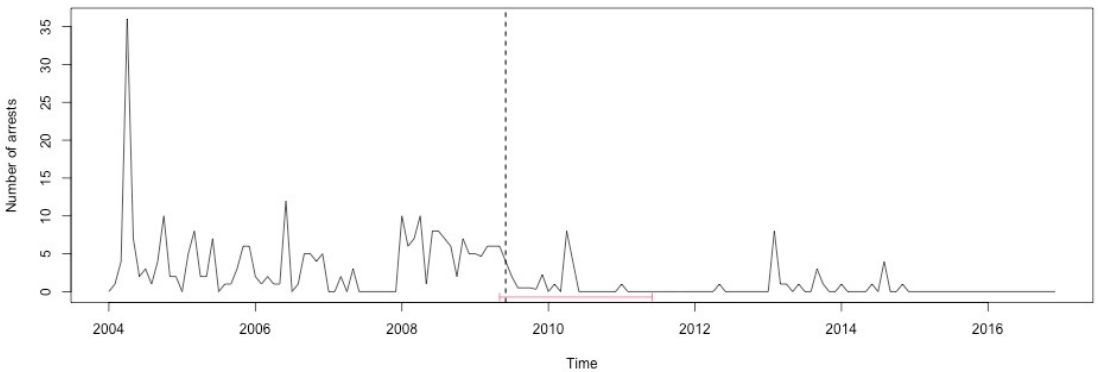
Figure A46. Heroin organized crime arrests 2004–2016 in the Czech Republic and structural breaks.